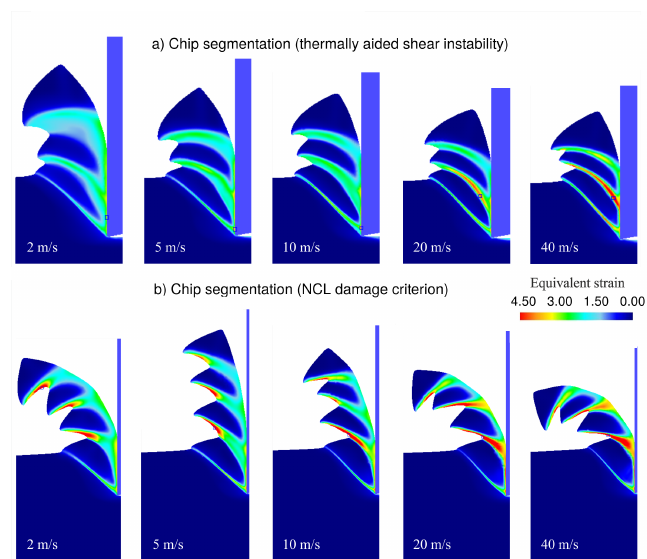
Figure 16. Equivalent strain ¯ (cid:101) contours during periodic chip segment formation under different speeds